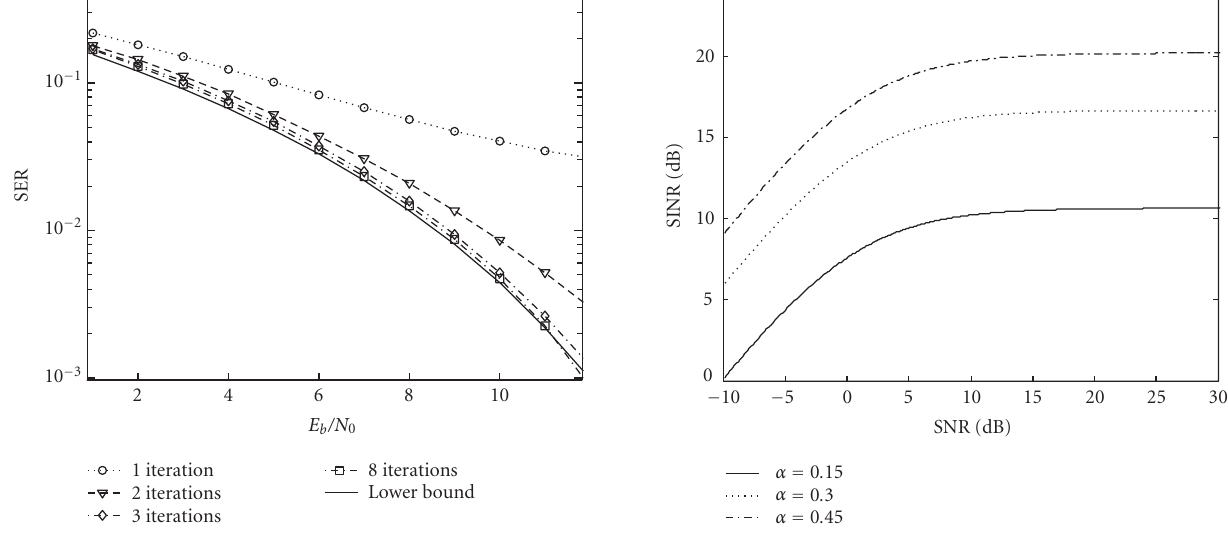
Figure 6: Signal-to-interference and noise ratio (SINR) for the cross-layer data link pipe based on watermark polarity modulation at di ff erence signal-to-noise ratio (SNR).